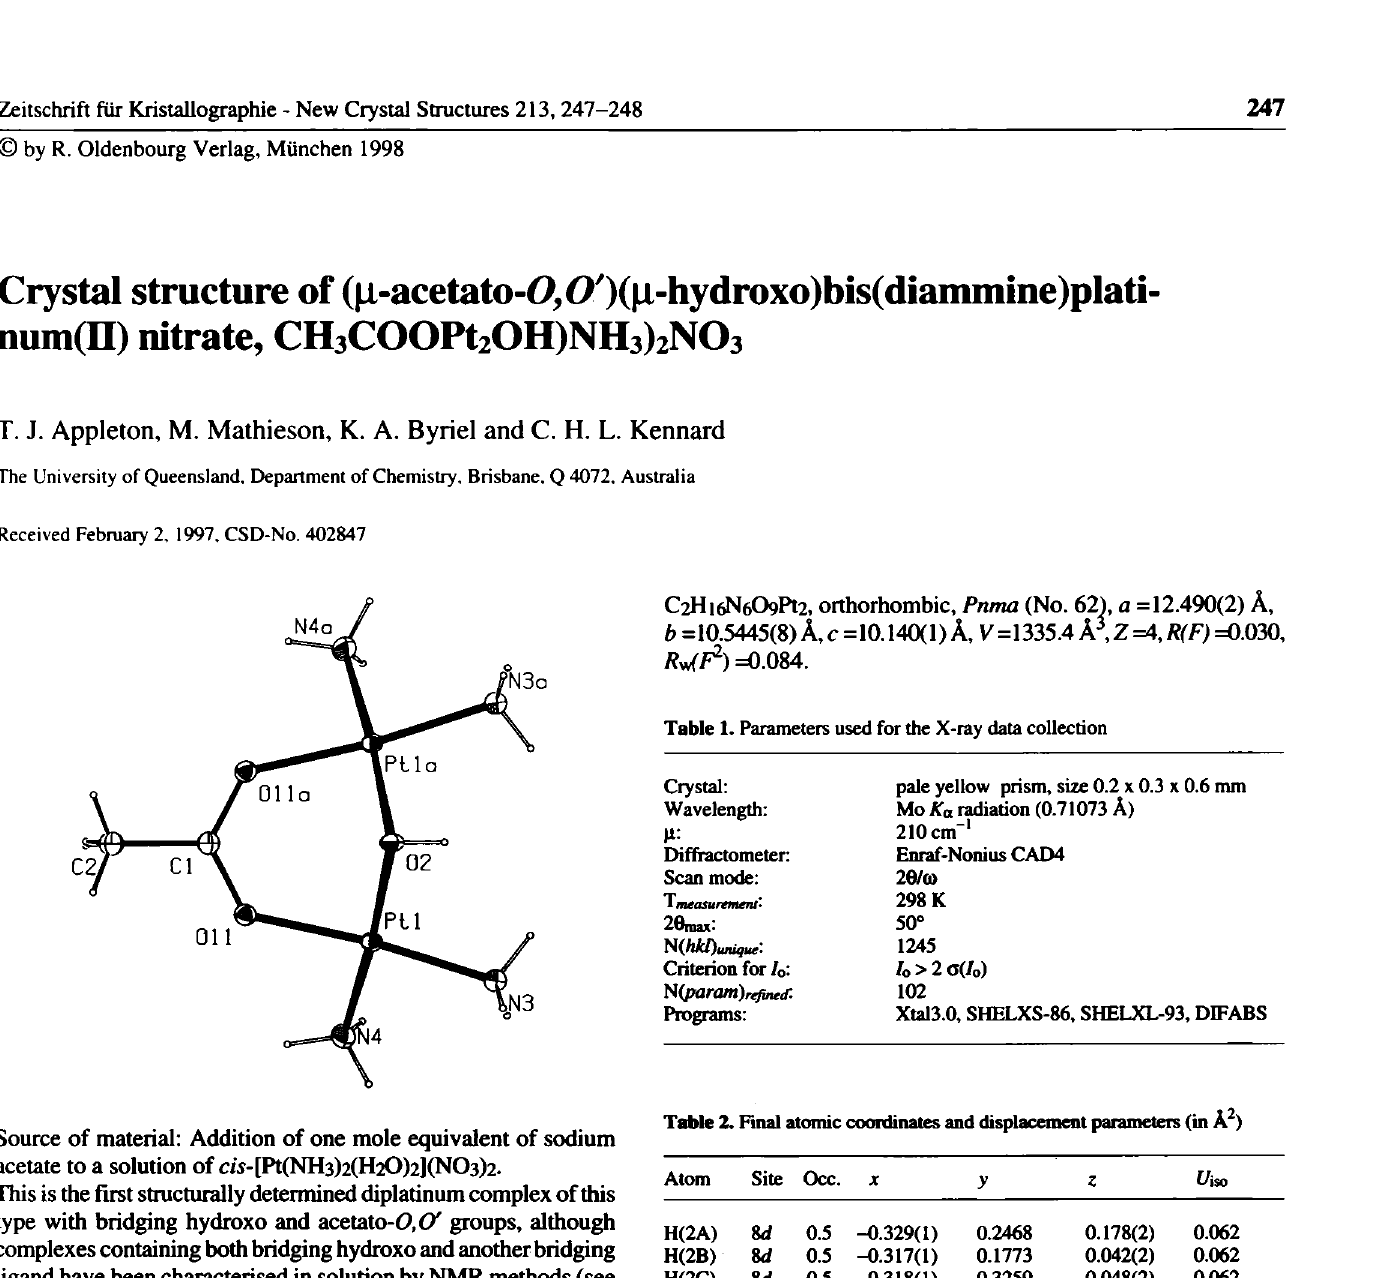
Table 2. Final atomic coordinates and displacemeot parameters (in